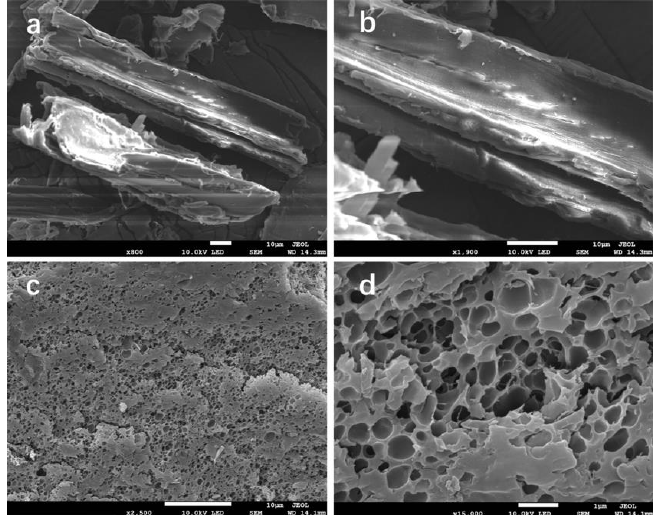
Figure 3. SEM images of sawdust ( a , b ) and the SW-AA-AM polymer ( c , d ).